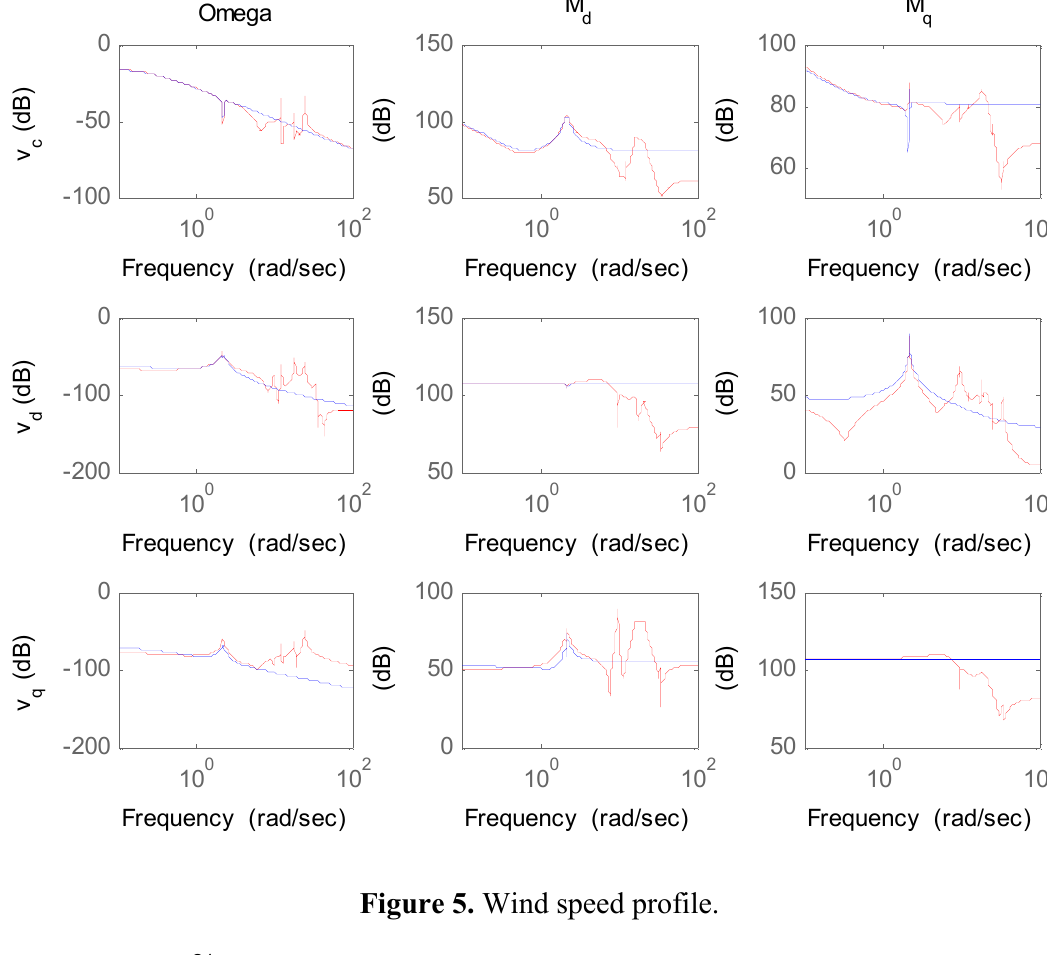
Figure 4. Frequency response from Coleman-transformed wind speeds to rotor speed, d- and q-axis blade moments, both for the high fidelity (red) and the simple models (blue).